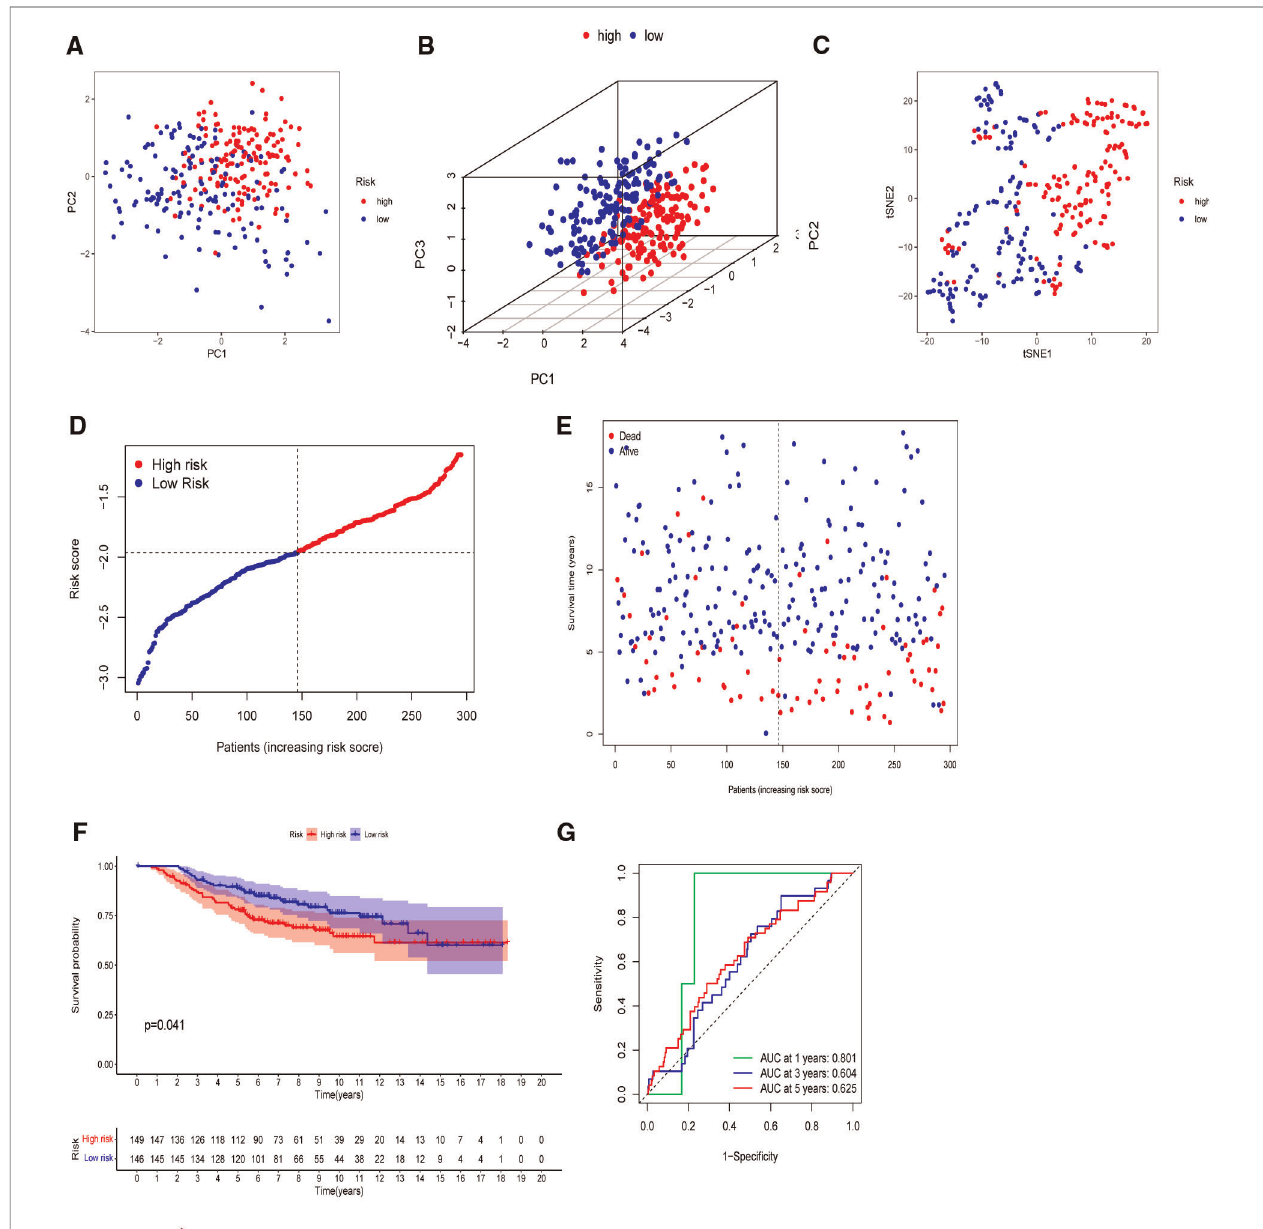
FIGURE 6 | Validation of the fi ve-gene model in the GEO cohort. ( A ) 2D PCA plot. ( B ) 3D PCA plot. ( C ) t-SNE analysis. ( D ) Distribution of calculated risk scores. ( E ) Survival status of BC patients. ( F ) Kaplan – Meier curves of high- and low-risk subgroups. ( G ) Time-dependent ROC